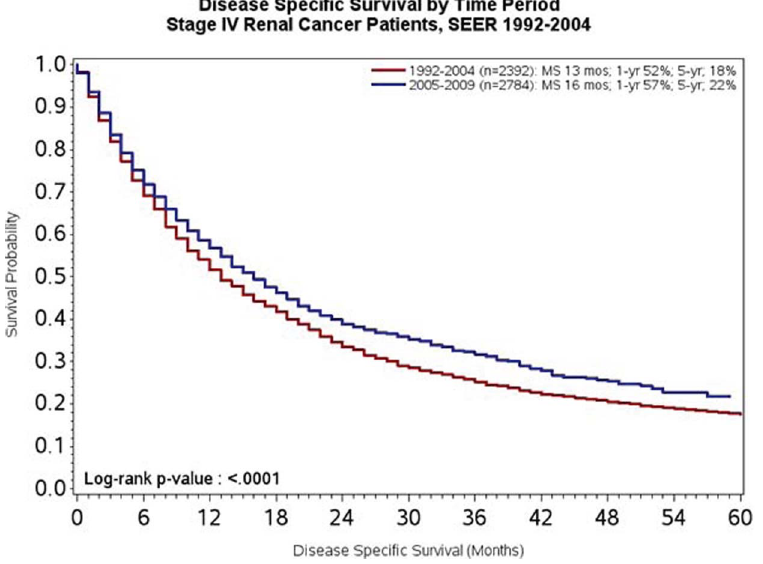
Figure 1. DSS of patients with denovo mRCC diagnosed from 1992 – 2004 as compared to 2005 – 2009.